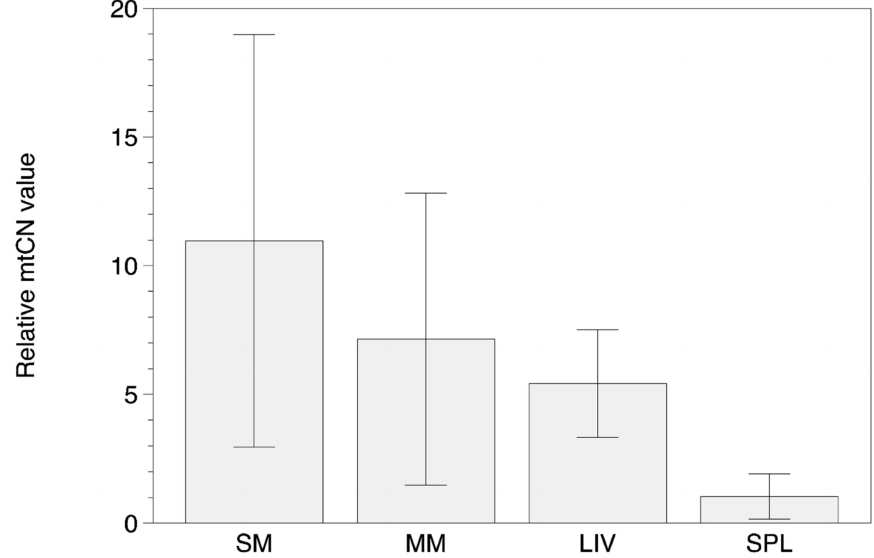
Figure 6. The relative MtDNA copy number (mtCN) values in tissue samples from skeletal muscle (SM), myocardial muscle (MM), liver (LIV) and spleen